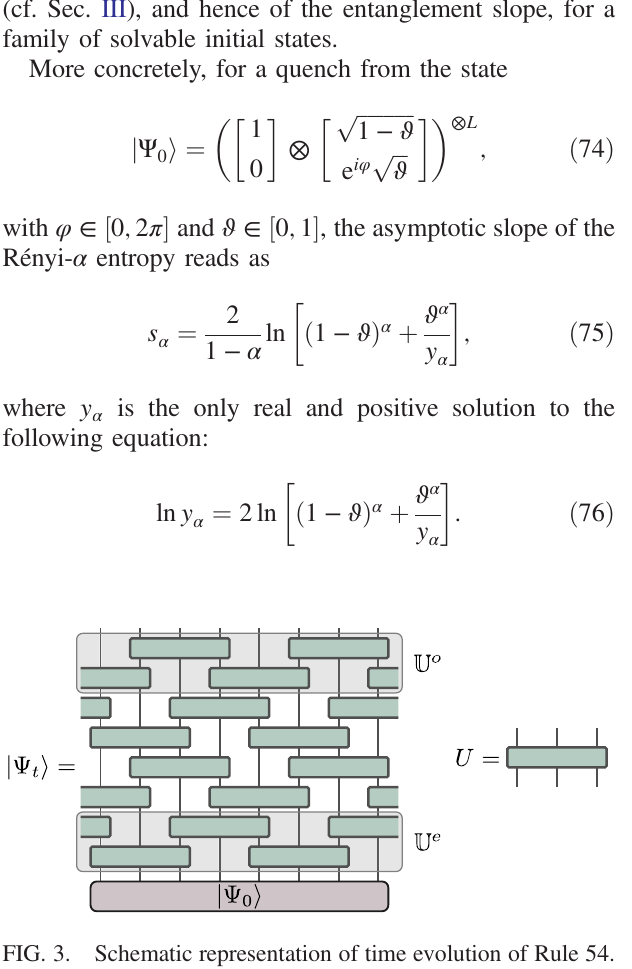
FIG. 3. Schematic representation of time evolution of Rule 54. most one site